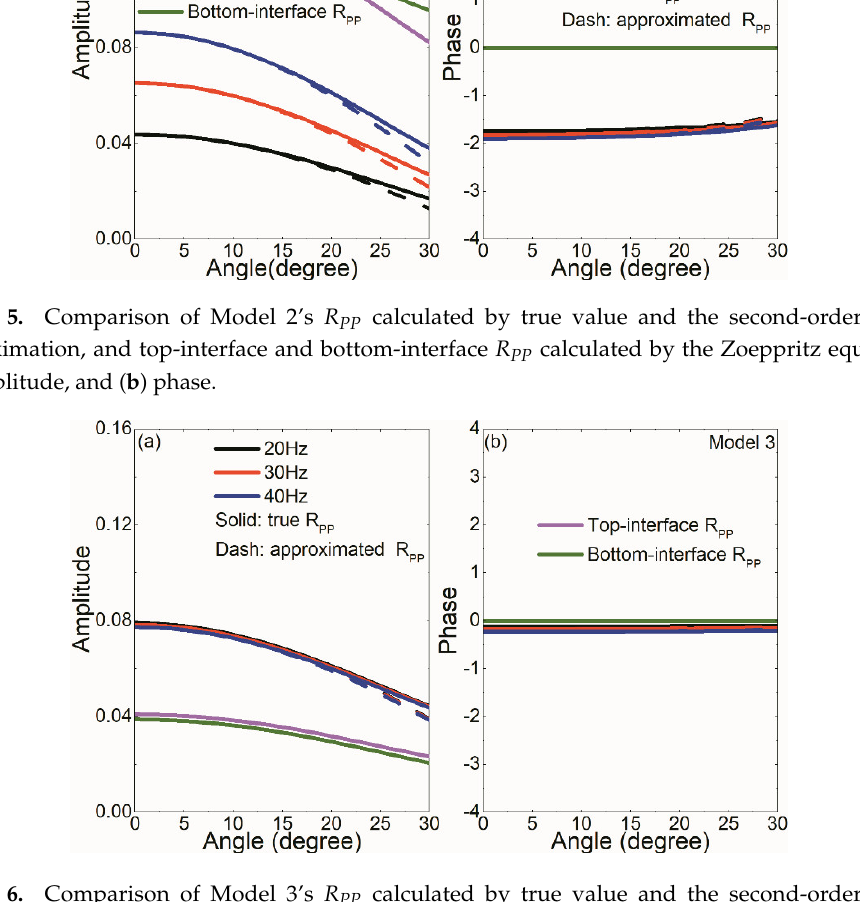
Figure 7. Comparison of Model 4’s R PP calculated by true value and the second-order series approximation, and top-interface and bottom-interface R PP calculated by the Zoeppritz equations, ( a ) amplitude, and ( b ) phase. Figures 6 and 7 show R PP of Models 3 and 4 versus incidence angles, respectively. Models 3 and 4 are impedance transition thin beds with equal polarities, which differ from opposite polarities of Models 1–2. Constructive interference effects cause that thin-bed reflected amplitudes are higher than those of top- and bottom-interfaces. Compared with Models 1–2 cases, R PP ’s amplitudes of Models 3 and 4 are less sensitive to frequency variation. The approximate Amplitude-Versus-Angle (AVA) curves coincide with the true AVA curves for incidence angles smaller than 20 degrees and deviate progressively from the true for incidence angles over 20 degrees. Comparison of Models 3 and 4 shows that the former’s phases are nearly zero while these of the latter are nearly π.